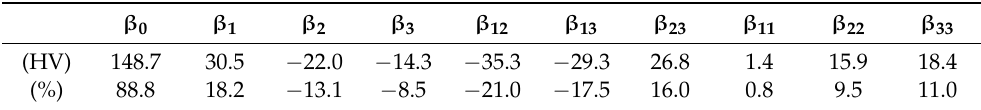
Table 5. Regression coefficients for the hardness response considering x 1 , x 2 , x 3 (in codified units) and f out in HV and percentage over the mean hardness